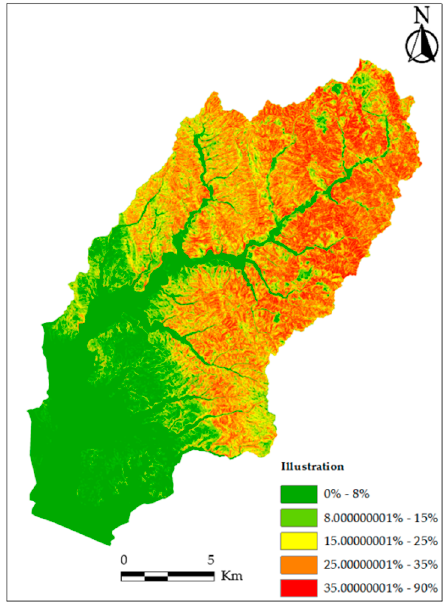
Figure 4. The slope degree map of the Atsuma River basin.